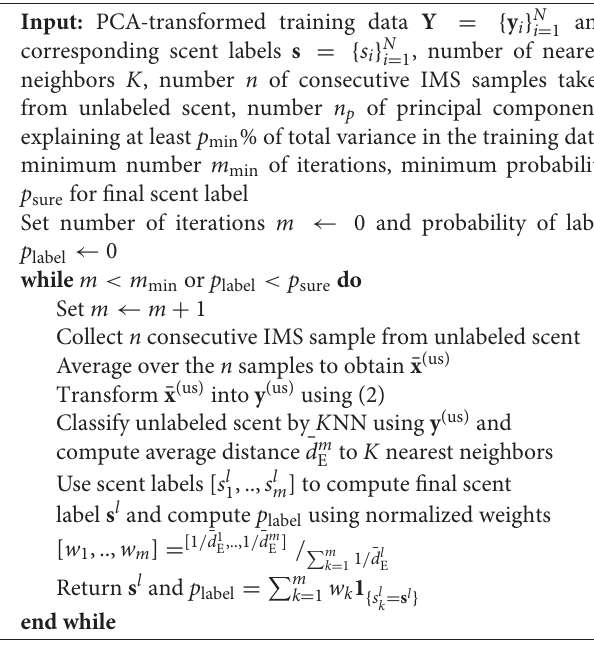
Algorithm 1: Pseudo-code of scent